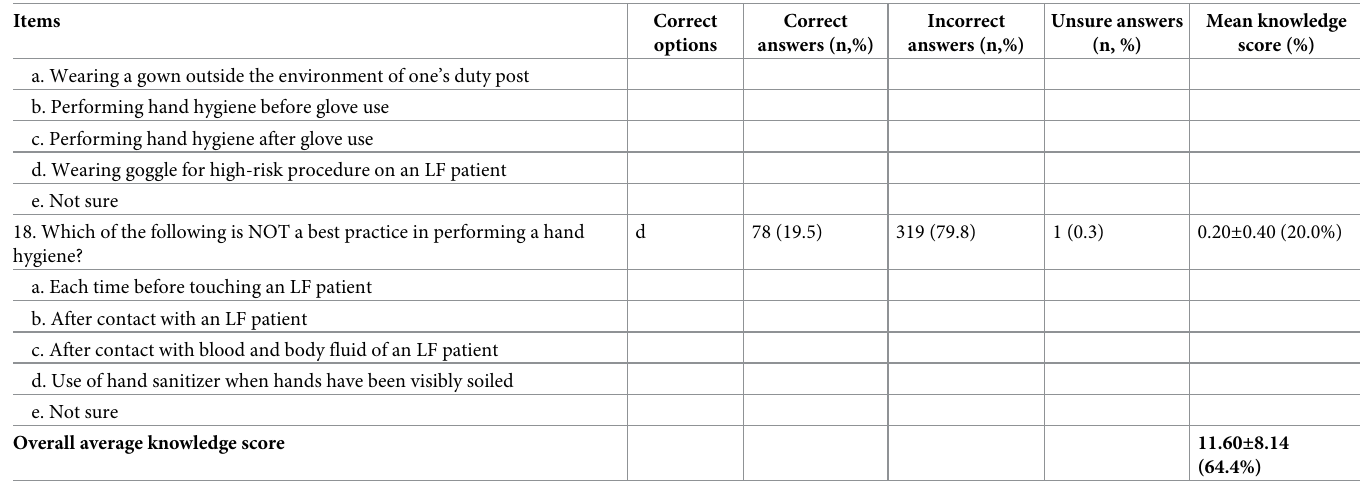
cated the following significant associations between independent variables and the second dependent categorical variable (levels of LF knowledge differentials-no overestimation and over-estimation): age group- χ 2 (3, n = 276) = 20.08, p < 0.0005, Cramer’s V = 0.27; years of